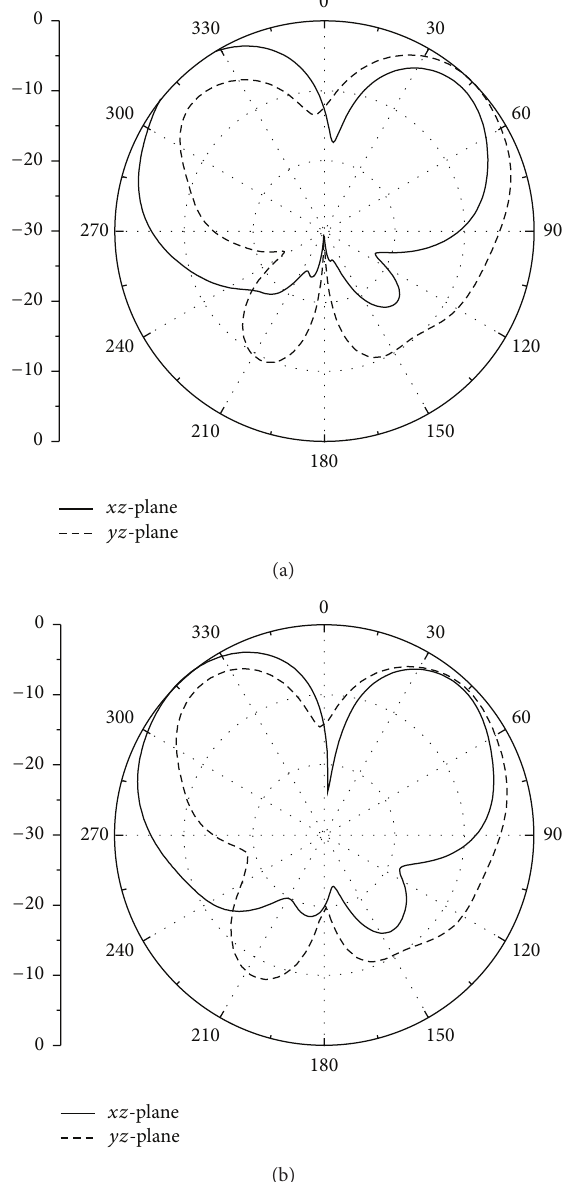
Figure 11: The simulated radiation pattern of the patch array at 4.5 GHz. (a) Without DGS; (b) with DGS.